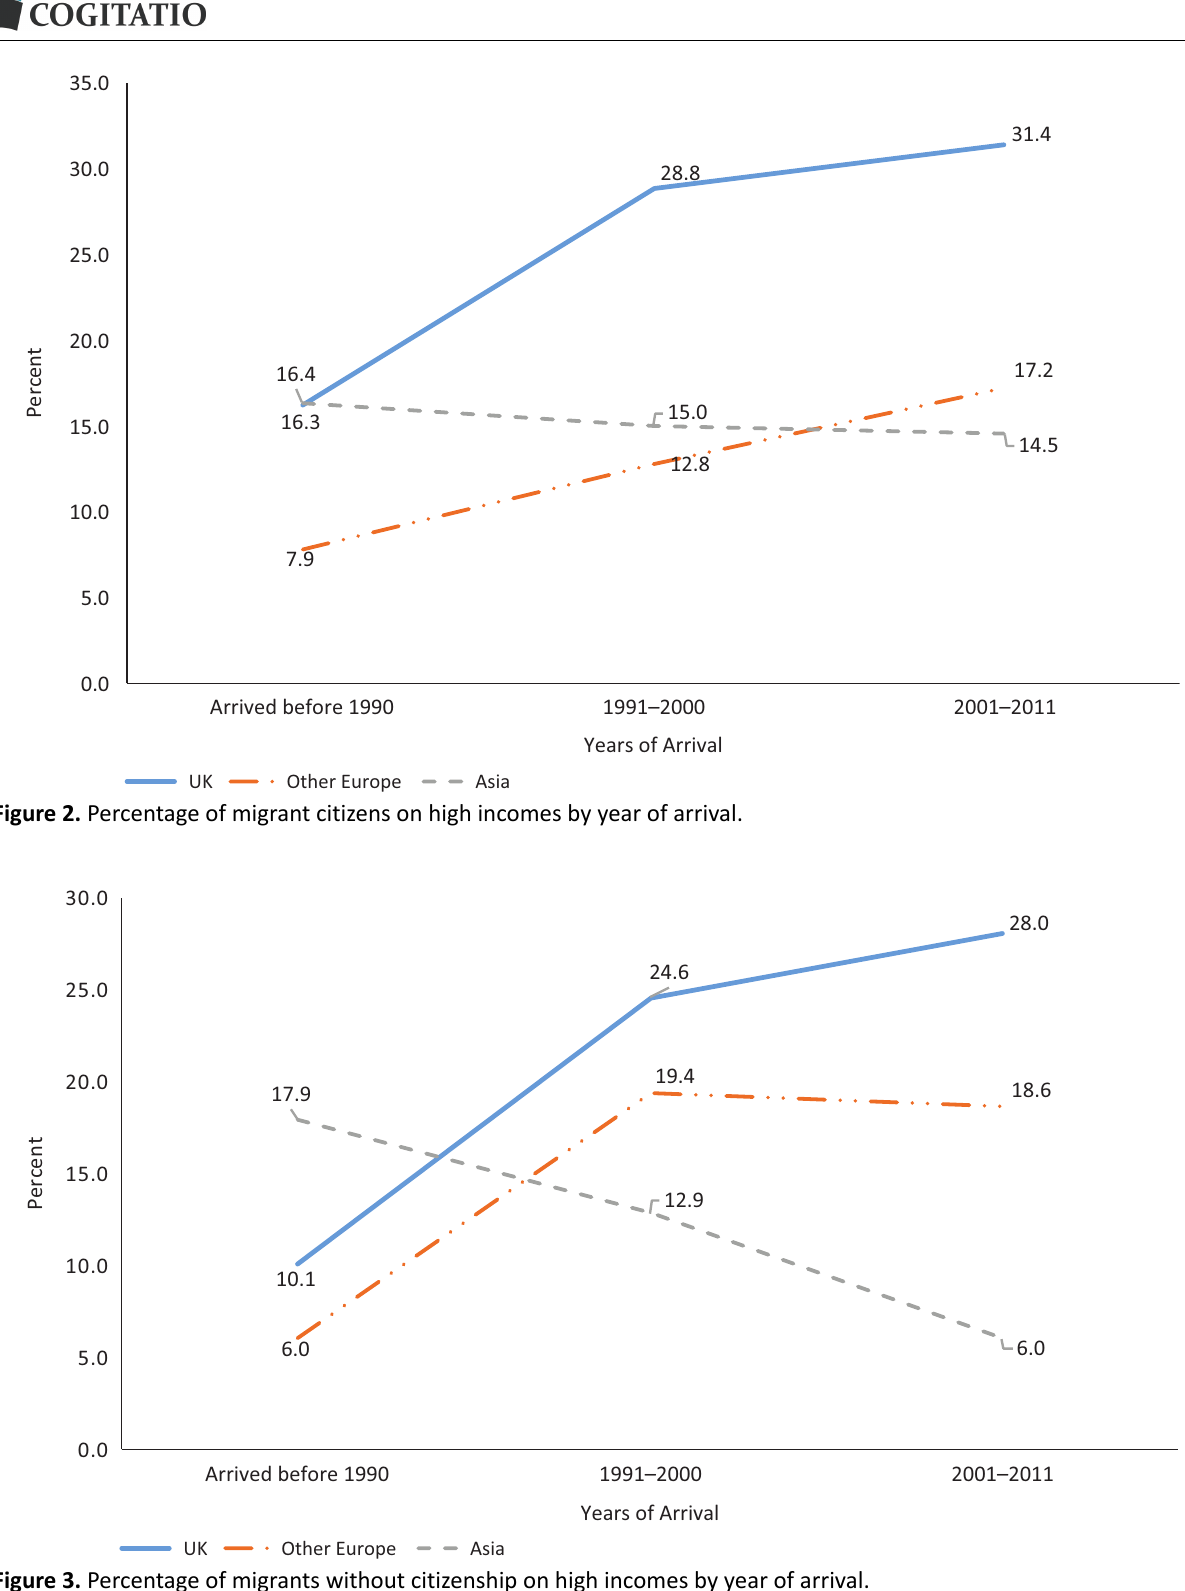
Figure 3. Percentage of migrants without citizenship on high incomes by year of